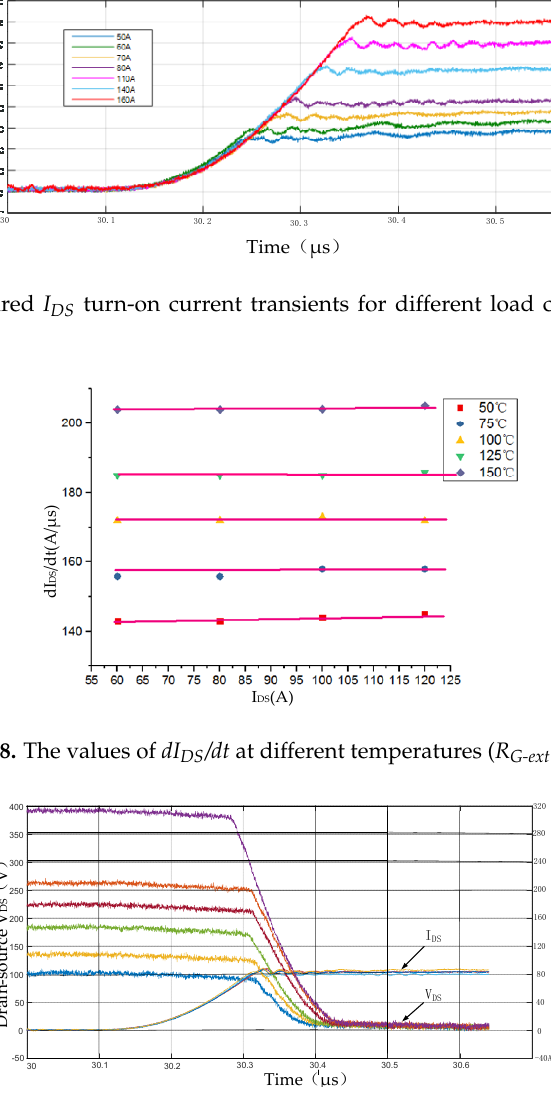
Figure 9. The turn ‐ on I DS and V DS waveforms at different DC ‐ link voltages.